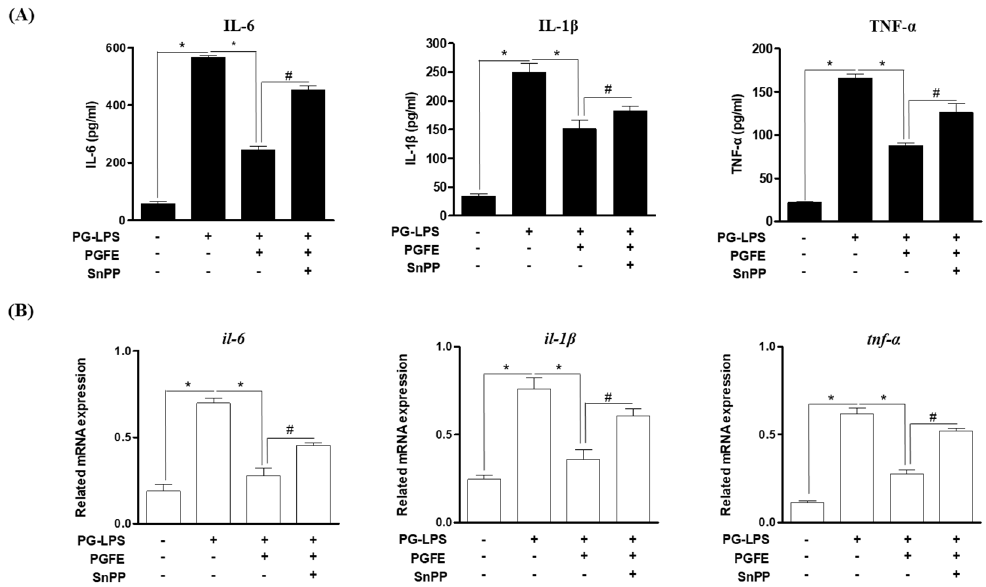
Figure 5. Inhibitory E ff ect of PGFE through by HO-1 on PG-LPS induced pro-inflammatory cytokines. The HPDL cells were pretreated with the indicated concentration of PGFE (200 µ g / mL) for 6 hr and then incubated with PG-LPS for 24 hr. ( A ) The production of pro-inflammatory cytokines interleukin (IL)-6, IL-1 β and tumor necrosis factor- α (TNF- α ) were determined by ELISA kit assay. ( B ) The mRNA levels of pro-inflammatory cytokines genes and il-6 , il-1 β , and TNF- α genes were determined by real-time PCR analysis. The results were normalized to gapdh expression. * p < 0.05 vs. only LPS treated group; # p < 0.05 vs. LPS + PGFE treated group.